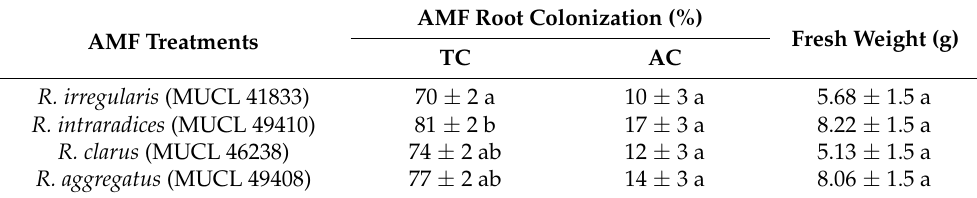
Table 1. AMF-root colonization (TC% and AC%) and total fresh weight (TFW) averaged between the two-time samplings (T0 and T1) of A. officinalis associated with each AMF species ( R. irregularis , R. intraradices , R. clarus and R. aggregatus ) growing for 9 days in the semi-hydroponic cultivation system. AMF Root Colonization (%) Fresh Weight (g) AMF Treatments TC AC R. irregularis (MUCL 41833) 70 ± 2 a 10 ± 3